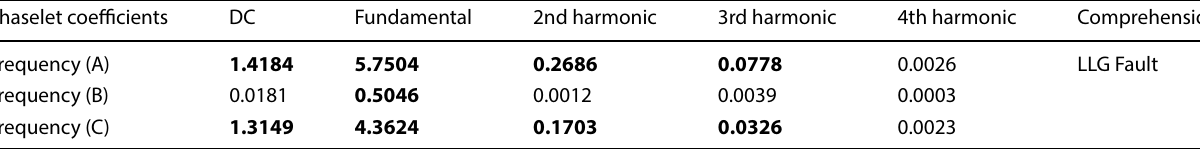
Table 4 Phaselet coefficients under LLG fault